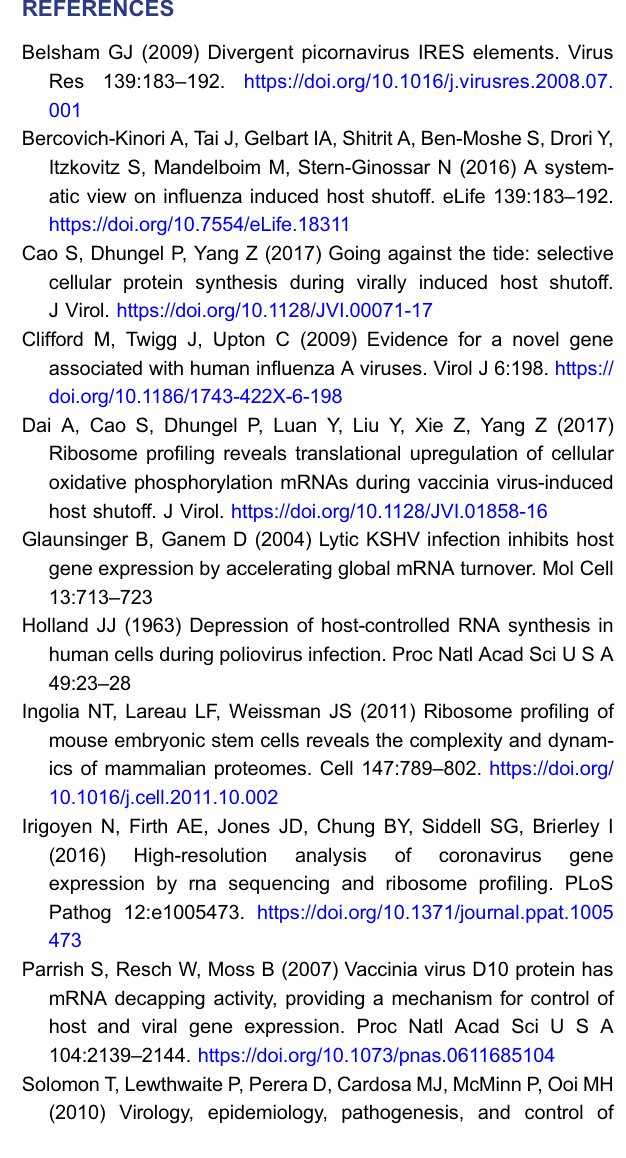
b Figure 2. EV71 protein is preferentially synthesized through both abundant mRNA production and advantageous mRNA translation . (A) Log 10 TE vs. log 10 mRNA RPKM of host cell coding genes and EV71 polypeptide coding gene were plotted. Genes from mock- (cyan) and EV71-infected (purple) cells at each time point are shown in the same picture. The cross (red) shows EV71 mRNA. Only genes with a RPKM >0.3 under all conditions are shown. (B) Genome-wide EV71 RNA, RPF coverage and RPF/RNA ratio (TE). Three time points from Set 1 are shown. Data are displayed using Mochiview. EV71 genomic RNA and its subunit regions are shown on top. (C) RD cells were transfected with 480 ng un-capped EV71-5UTR- fi re fl y- luciferase-Poly (A) mRNA and 20 ng m 7 G capped EIF3C - 5UTR-renilla-luciferase-Poly (A) mRNAs. One hour after trans- fection, cells were infected with EV71 at an MOI of 40 or mock infected. At the indicated time post infection, luciferase activities were measured. The ratios of fi re fl y luciferase and renilla luciferase activities in EV71- and mock-infected cells are shown, respectively. A Western blot analysis is shown to indicate similar amounts of cell lysates used. (D) The ratios of fi re fl y luciferase activities normalized by renilla luciferase activities in EV71- and mock-infected cells are shown. The results are the averages of three independent experiments. The error bars indicate standard deviations. * P < 0.05, *** P < 0.001, **** P < 0.0001 (unpaired t